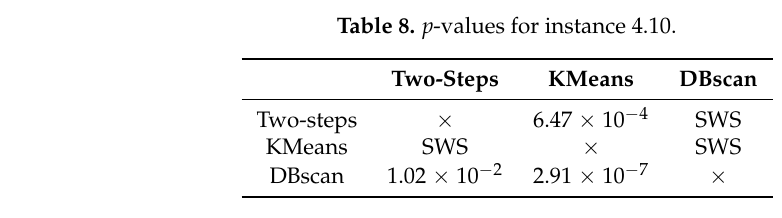
Table 9. p -values for instance 5.10.